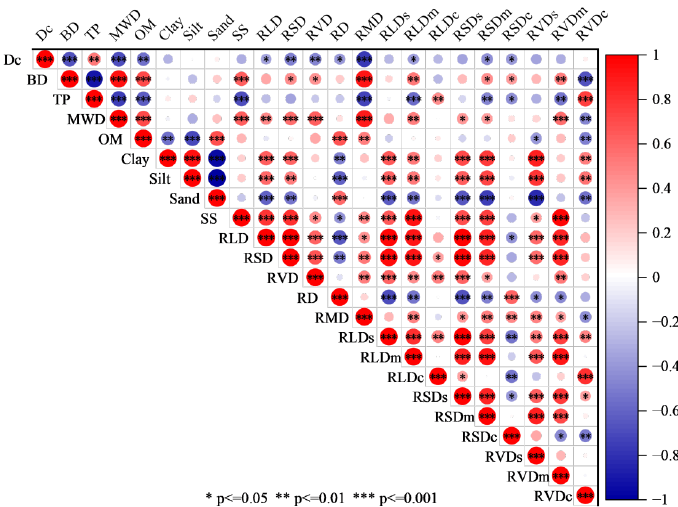
Figure 4. Pearson correlation between root characteristics, soil properties, and soil detachment capacity for different land use types. Notes: Dc, soil detachment capacity; RLD, root length density; RSD, root surface area density; RVD, root volume density; RD, root diameter; RMD root mass density; RLDs, root length density of D ≤ 0.5 mm diameter class; RLDm, root length density of 0.5 mm < D ≤ 1 mm diameter class; RLDc, root length density of D ≤ 0.5 mm diameter class; RSDs, root surface area density of D ≤ 0.5 mm diameter class; RSDm, root surface area density of 0.5 mm < D ≤ 1 mm diameter class; RVDc, root surface area density of D ≤ 0.5 mm diameter class; RVDs, root volume density of D ≤ 0.5 mm diameter class; RLDm, root volume density of 0.5 mm < D ≤ 1 mm diameter class; RVDc, root volume density of D ≤ 0.5 mm diameter class; BD, soil bulk density; TP, soil porosity; MWD, aggregate stability; OM, organic matter; SS, shear strength.